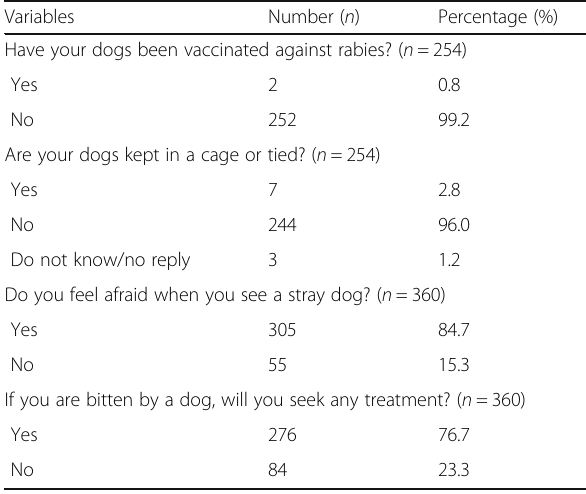
Table 5 Respondents ’ behaviors related to